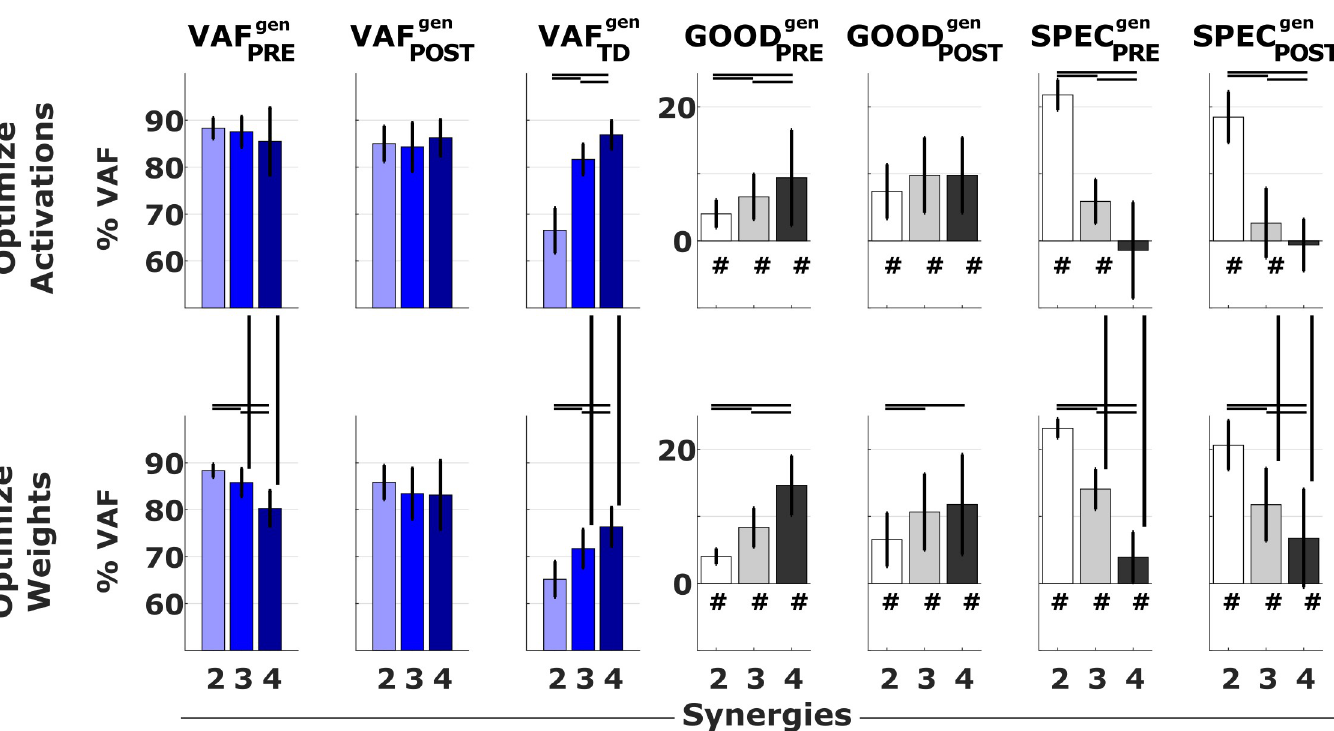
Fig 5. VAF when using the generic synergies. Results from the EMG reconstructions using generic synergies. Colored bars report mean and standard deviation of the VAF values in the PRE, POST and TD conditions. Grey bars report the differences GOOD PREgen = VAF PRE − VAF PREgen , GOOD POSTgen = VAF PRE − VAF POSTgen , SPEC PREgen = VAF PREgen –VAF TDgen and SPEC POSTgen = VAF POSTgen –VAF TDgen . Black lines indicate significant differences (p < 0.05). The symbol # indicates values of GOOD and SPEC that are significantly (p < 0.05) greater than